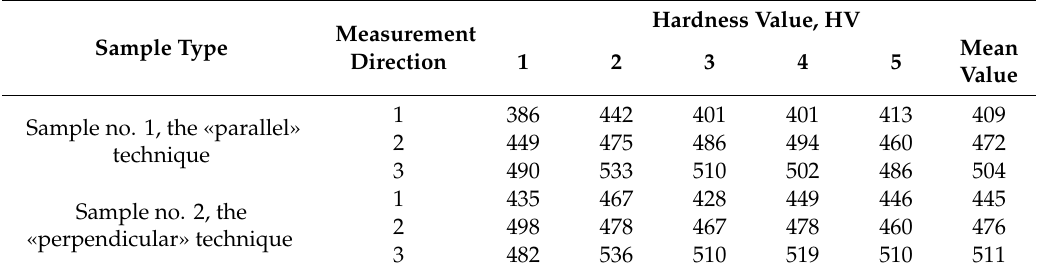
Table 2. Results of hardness measurements.